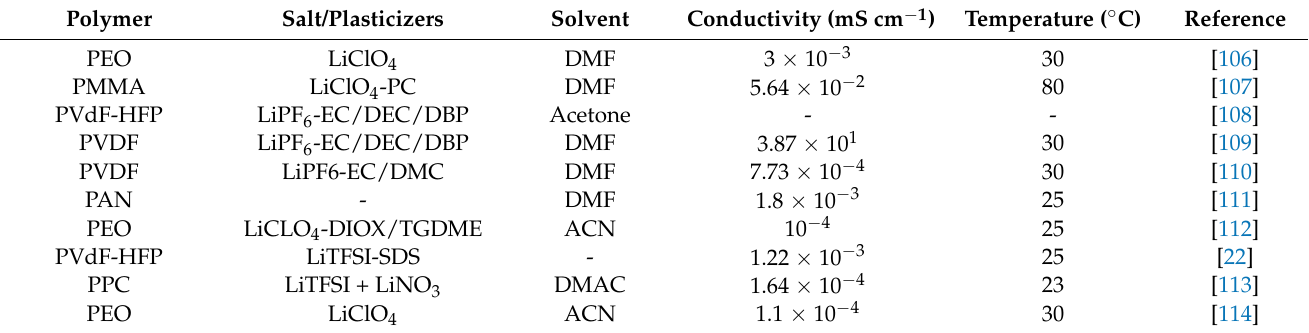
Table 3. List of GPEs with SiO 2 filler with their conductivity and